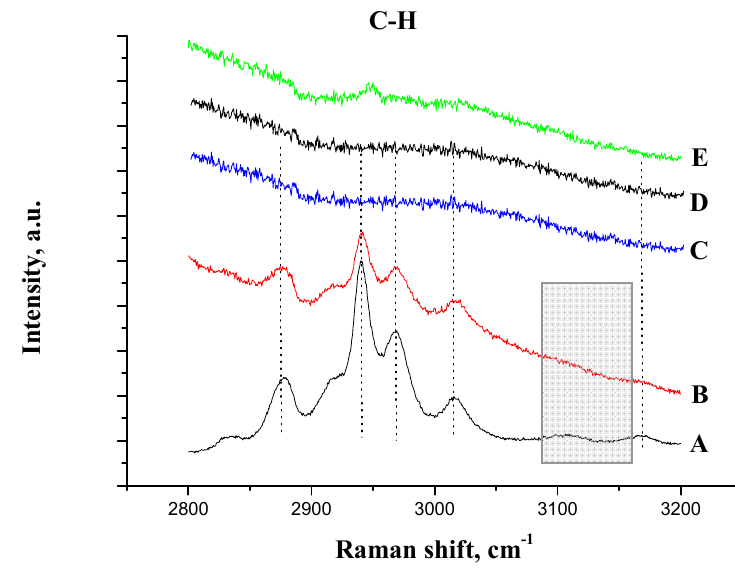
Figure 6. Raman spectra (C-H stretch region) of the studied samples ( A ) unsupported IL, ( B ) 20IL/ γ -Al O MOD, ( C ) Au/20IL/ γ -Al 2 3 (NaBH ), ( E ) Au/20IL/ γ -Al O MOD (NaBH 4 2 3